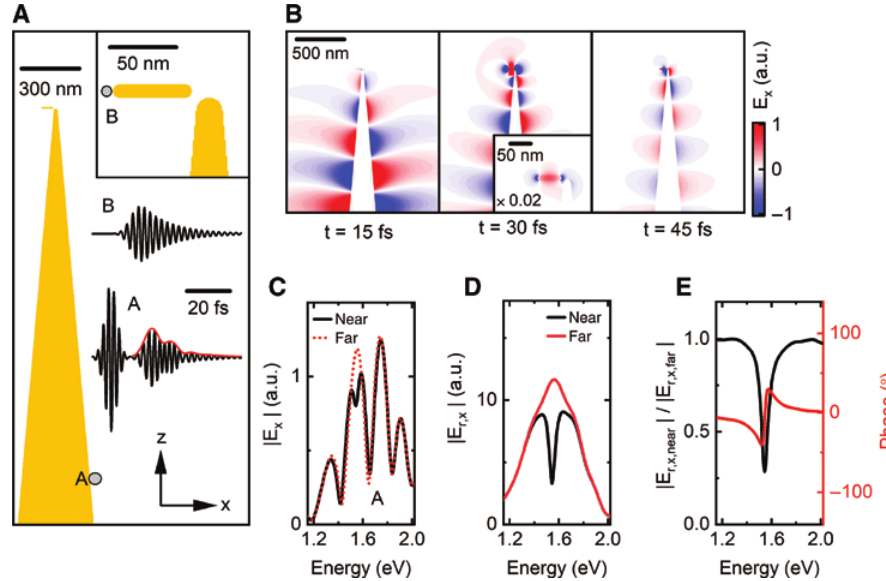
Figure 5: Finite-difference time-domain simulation of the PNSI experiment. (A) A conical gold tip is excited by a 7-fs SPP pulse in the m = 0 mode. The nanofocused SPP pulse couples to a small gold nanorod (see inset). The field component E at point A shows the incident pulse followed by the pulse E backreflected from the apex. E contains the x r , x r , x directly reflected apex field and the re-emitted nanorod field. Near the rod apex (point B), the field shows the nanorod FID. (B) Snapshots of E demonstrating the nanofocusing of SPPs to the apex (left), their interaction with the rod (middle), and backpropagation (right). The inset x highlights the excitation of the nanorod. (C) FT spectrum of E at point A for tip-nanorod distances of 3 nm (“near”, black) and 100 nm (“far”, x red). The near-field coupling to the rod is seen around 1.55 eV. (D) FT of E at point A, emphasizing light absorption by the nanorod (black). r , x (E) Amplitude (black) and phase spectrum (red) obtained by normalizing the complex-valued FT spectra of E when the tip is “near” the rod r , x to that with the tip “far” from